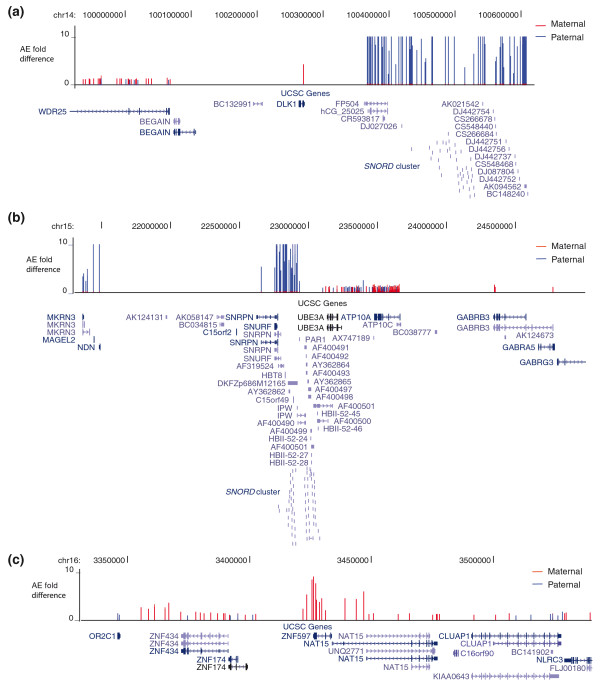
Examples of imprinted genomic regions in fibroblasts. (a) Paternally expressed imprinted region on chr14 covering numerous non-RefSeq genes found downstream of the paternally imprinted DLK1 gene (was not informative in our samples). This region has been previously identified in mice and sheep. (b) Extension of imprinting with paternal expression downstream of the SNRPN/SNURF loci encompassing multiple non-RefSeq genes. (c) Maternally expressed imprinted gene ZNF597 with upstream imprinted isoform-specific NAT15.